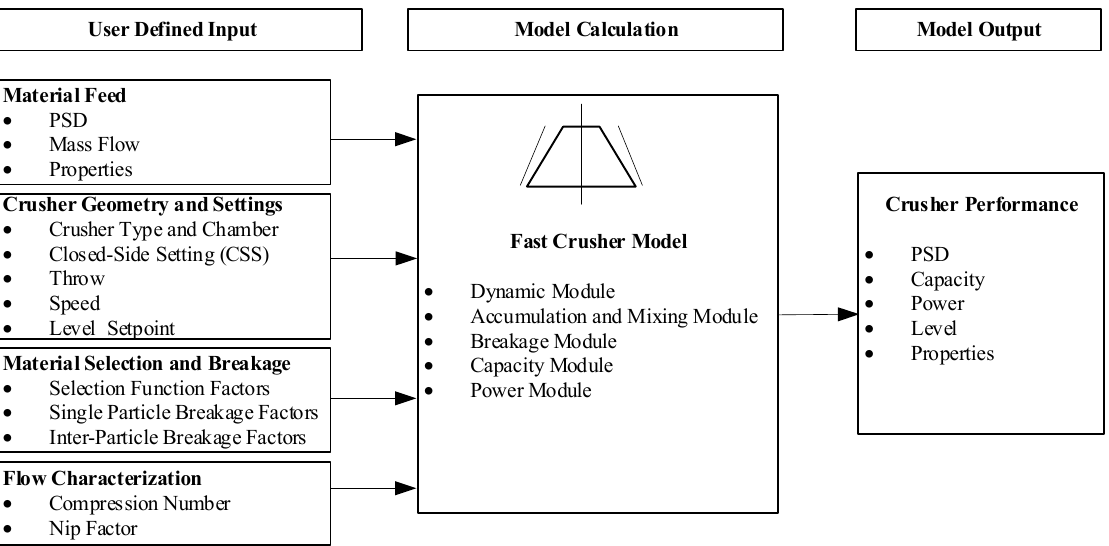
Figure 3. Overview of the fast-mechanistic crusher model implemented in Matlab/Simulink environment. The property changes after each compression are sequentially calculated based on the defined compression zones using the input from the dynamic module; see Figure 4. The selection (S) and breakage (B) functions are based on the nominal response of the compression tests carried out for a particular material type [12].